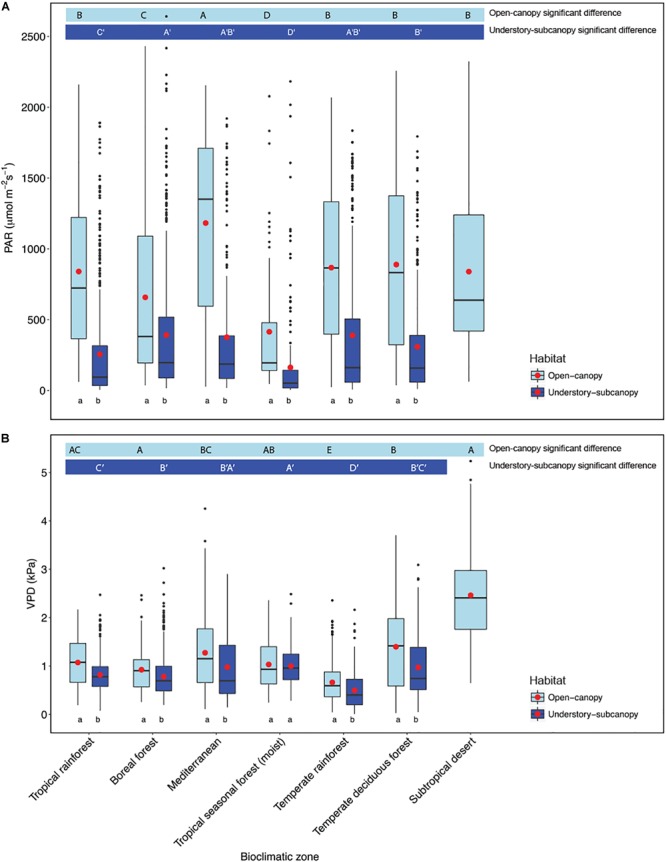
Boxplots comparing (A) photosynthetically active radiation (PAR) and (B) vapor pressure deficit (VPD) of the open-canopy and understory-subcanopy habitats in each bioclimatic zone. Boxplots are arranged following Figure 3, i.e., from the highest to the lowest average gsmax according to open-canopy habitat. Capital letters above boxplots designate pairwise comparison across bioclimatic zones using Wilcoxon rank-sum with Bonferroni correction (P < 0.05) for open-canopy (without apostrophe, first row) and understory-subcanopy (with apostrophe, second row), (the same letter means the variables are not significantly different while a different letter means they are significantly different). Kruskal–Wallis test was used to analyze differences across bioclimatic zones. Lower-case letters below boxplots indicate comparison of habitats in the same bioclimatic zone by two-sample Wilcoxon rank-sum. Boxes represent the interquartile range (IQR), horizontal line within boxes represents the median, the red dot represents the mean and whiskers extend to 1.5 times the IQR; black dots are outliers.